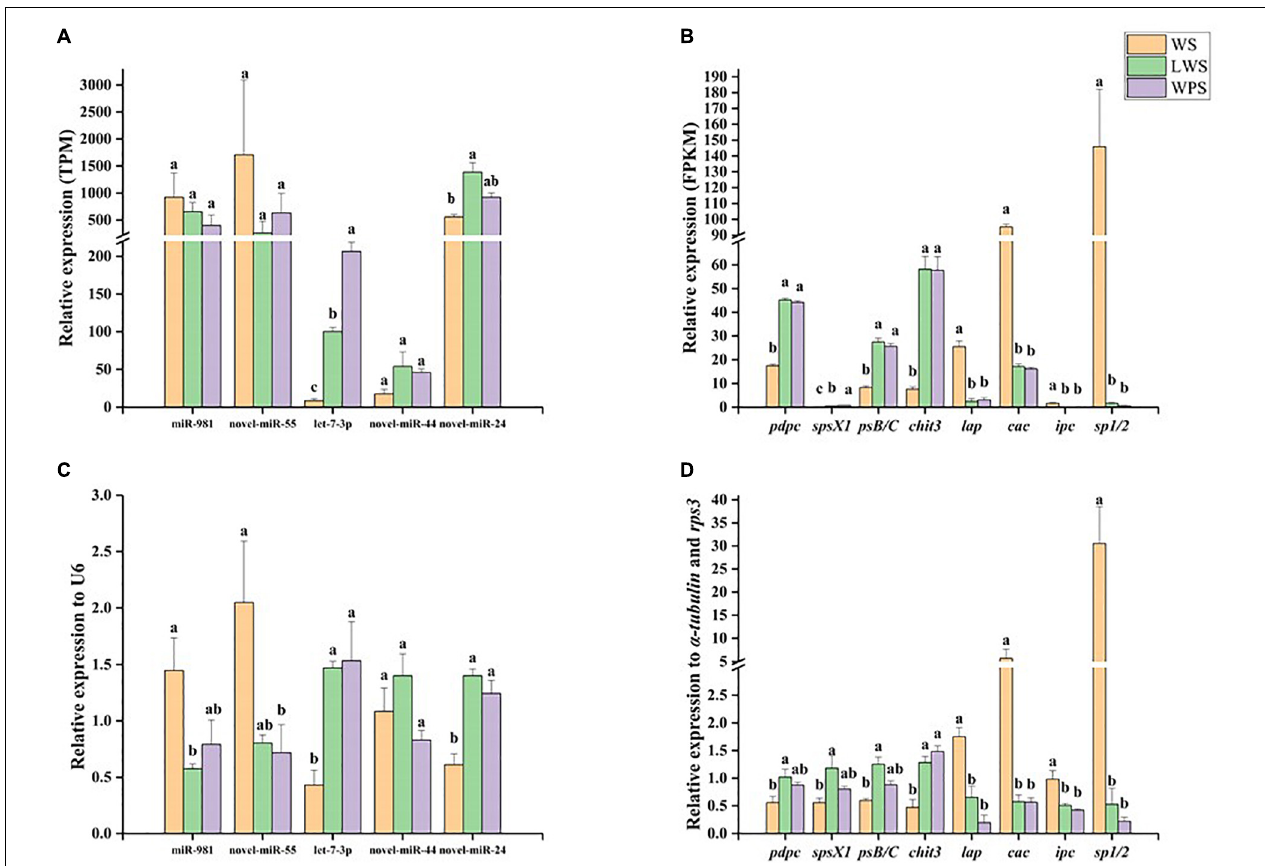
FIGURE 3 | The expression patterns of differentially expressed miRNAs and their predicted differentially expressed mRNA targets were analyzed by quantitative real-time PCR (qPCR) in wandering stage (WS), late wandering stage (LWS, the body contraction just before pupariation) and white puparium stage (WPS) of Bactrocera dorsalis . The results of Illumina sequencing also showed here. They included (A) relative expression of five miRNAs in Illumina sequencing, (B) relative expression of eight targets in Illumina sequencing, (C) relative expression of five miRNAs in qPCR, (D) relative expression of eight targets in qPCR. The qPCR and Illumina sequencing results were analyzed with one-way analysis of variance (ANOVA), and the means were separated with Tukey’s HSD post hoc test ( P < 0.05). Error bars show the SE. Different letters indicate statistically significant difference among the three stages ( P <